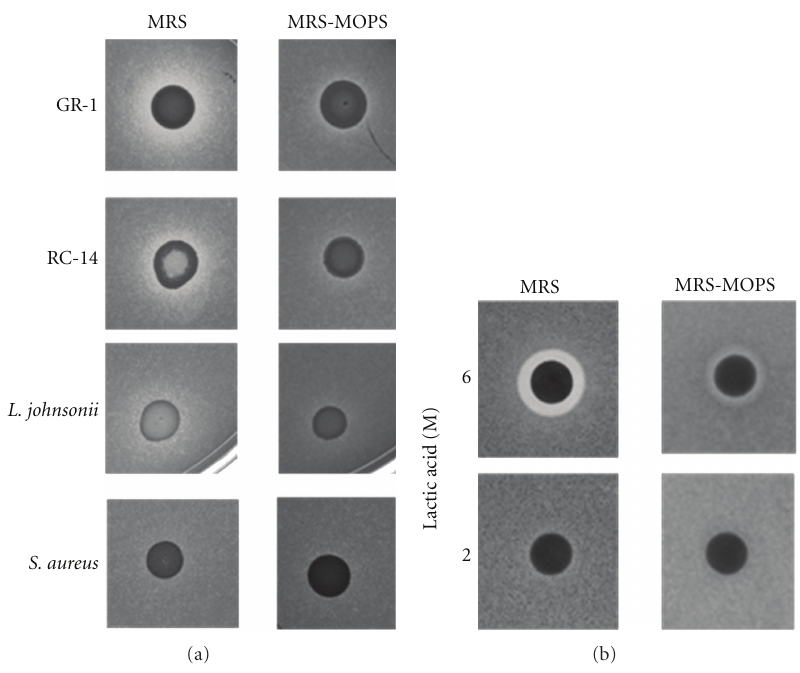
Figure 1: Agar inhibition assays with bacteria, lactic acid, and C. albicans . The images in (a) show the results of deferred agar overlay assays on bacterial colonies ( L. rhamnosus GR-1, L. reuteri RC-14, L. johnsonii PV016 , and S. aureus ATCC 25923) and C. albicans as the tester organism. The bacteria were spotted on MRS or bu ff ered MRS-MOPS (pH 7.0) plates. After incubation for 48 hrs, bacterial colonies were overlayed with soft agar containing live C. albicans cells and incubated for another 24hrs. For details see Section 2. A C. albicans lawn developed, but fungal growth was inhibited around the Lactobacillus colonies (clear zones), most predominantly around the probiotic strains GR-1 and RC-14. No inhibition was found with S. aureus . On MRS-MOPS bu ff ered to pH 7 inhibition zones are much smaller or absent indicating reduced e ff ectiveness of the lactobacilli. (b) Shows the results of disk di ff usion assays using lactic acid in the indicated molarities (20 µ L per disk) as the inhibitory compound. Plates were inoculated to produce a lawn of C. albicans and disks with lactic acid were immediately placed on the inoculated plates. Following 24hrs incubation, only the 6 M concentration of lactic acid showed an inhibition zone on MRS. Similar to the overlay assays, the inhibition zone on the bu ff ered MRS-MOPS medium was largely